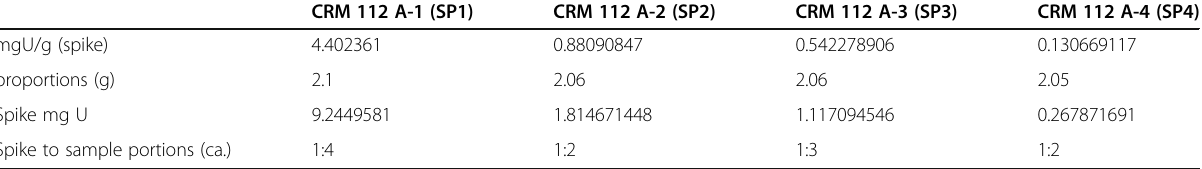
Table 2 CRM 112A Spike proportions with different diluted spike solutions (SP1, SP2, SP3, SP4)